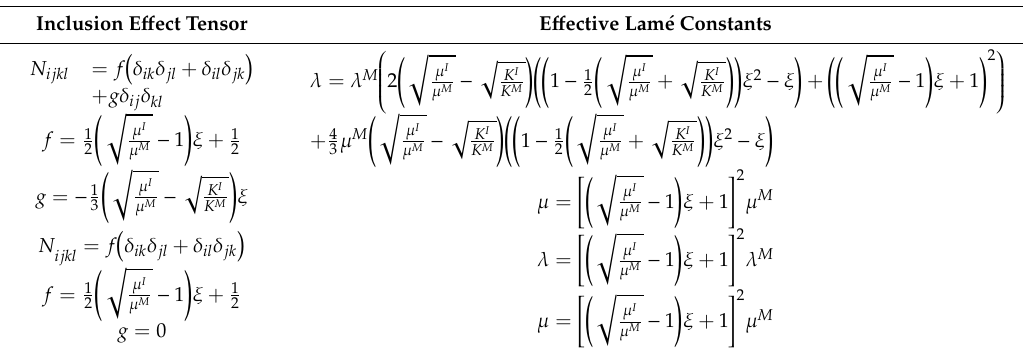
Table 2. E ff ective Lam é